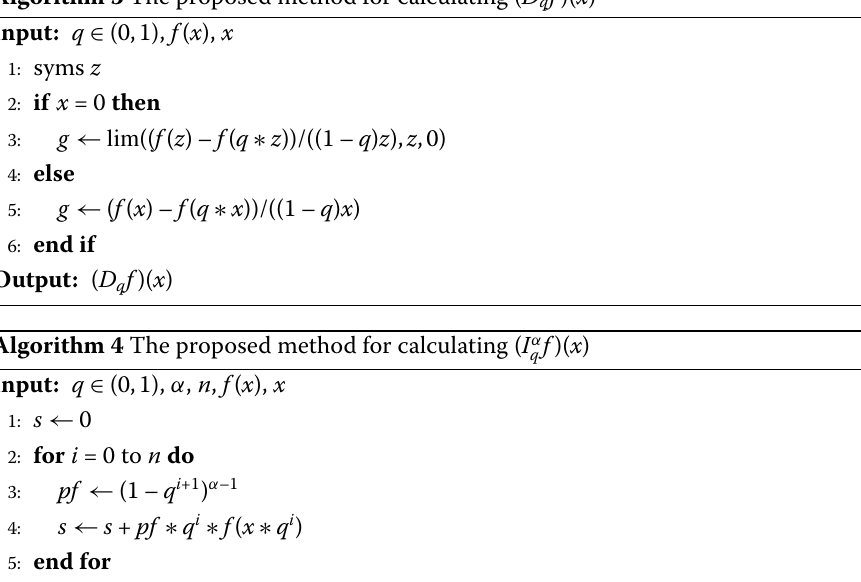
Algorithm 3 The proposed method for calculating ( D q f )( x )